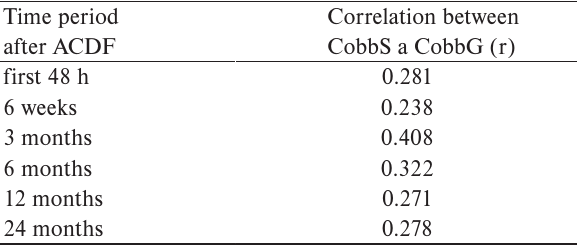
Table. 3. Correlation between SSP and GSP development after ACDF according to Pearson’s coefficient.